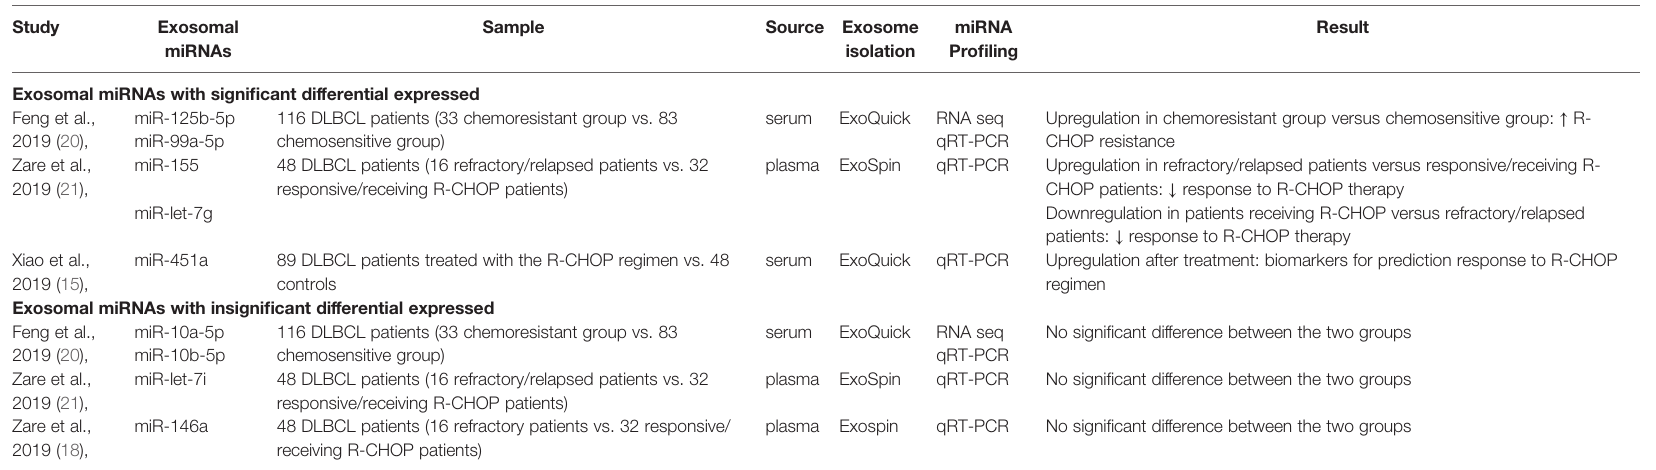
TABLE 5 | Exosomal miRNAs as predictor biomarkers for therapeutic ef fi cacy in